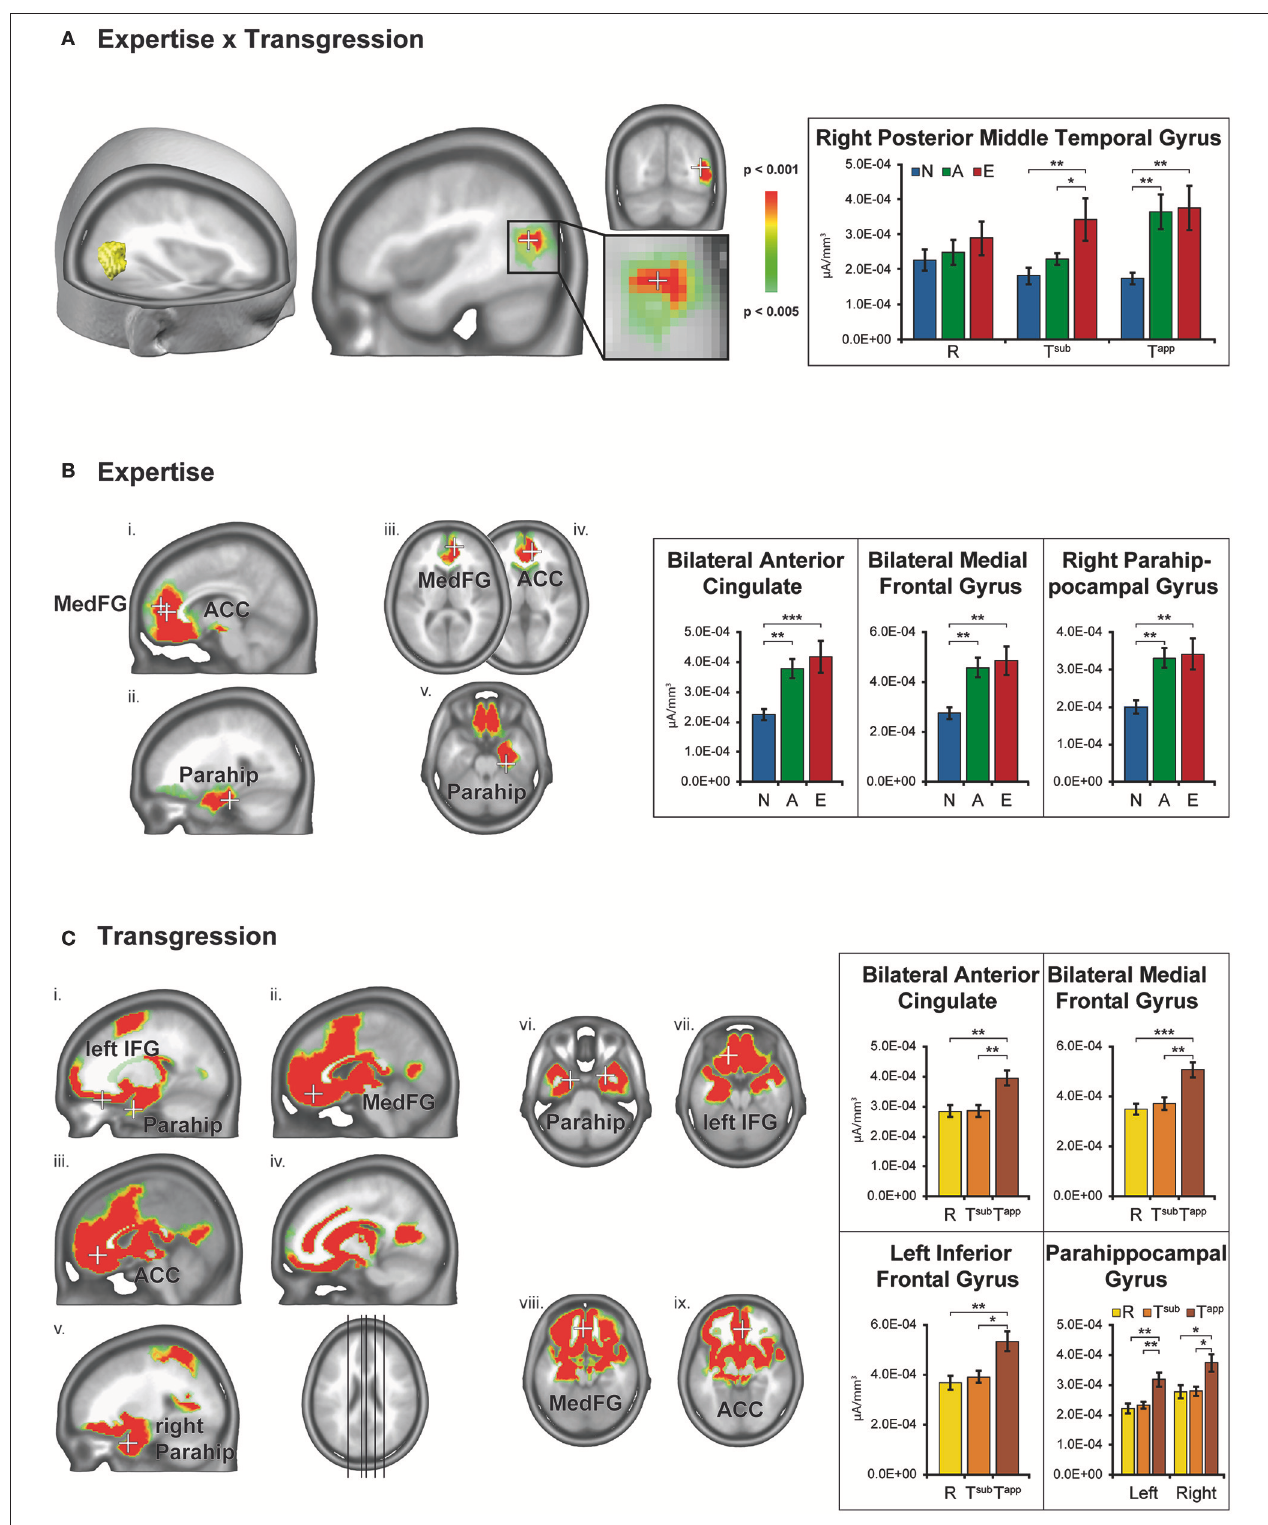
FIGURE 6 | Statistical parametric mapping of distributed electrical source estimations over the time-period after stimulus onset resulting from the microstate analyses (295–480ms). Results are depicted for Expertise × Transgression interaction (A) , main effect of Expertise (B) , and main effect of Transgression (C) . The bar graphs on the right depict the current densities of the peakvoxels indicated on the left by means of white crosses. N, Non-musicians; A, Amateurs; E, Experts; R, Regular; Tsub, Subtle transgression; Tapp, Apparent transgression. Asterisks indicate LSD-corrected contrasts between the groups. * p < 0.05, ** p < 0.01, *** p < 0.001.